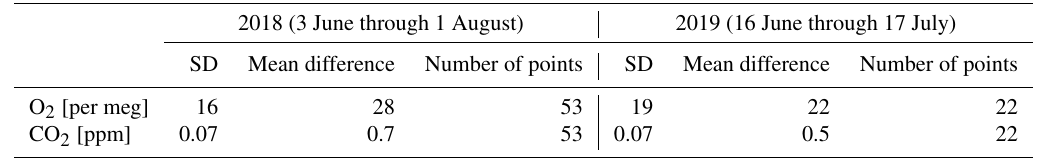
Table 1. The mean difference and the standard deviation (SD) of the target cylinder measurements of O 2 and CO 2 for the 2018 and 2019 periods separately, together with the number of data points used to calculate these specific